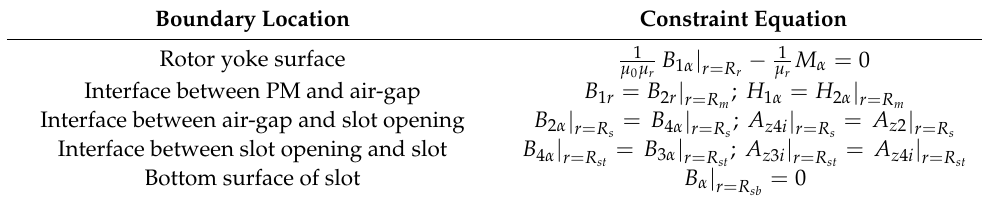
Table 2. Interface conditions between different